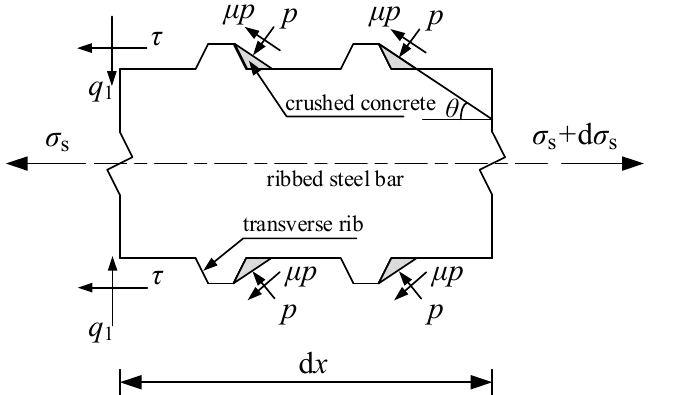
Figure 2. Interaction between the ribbed steel bars and the surrounding concrete under load.